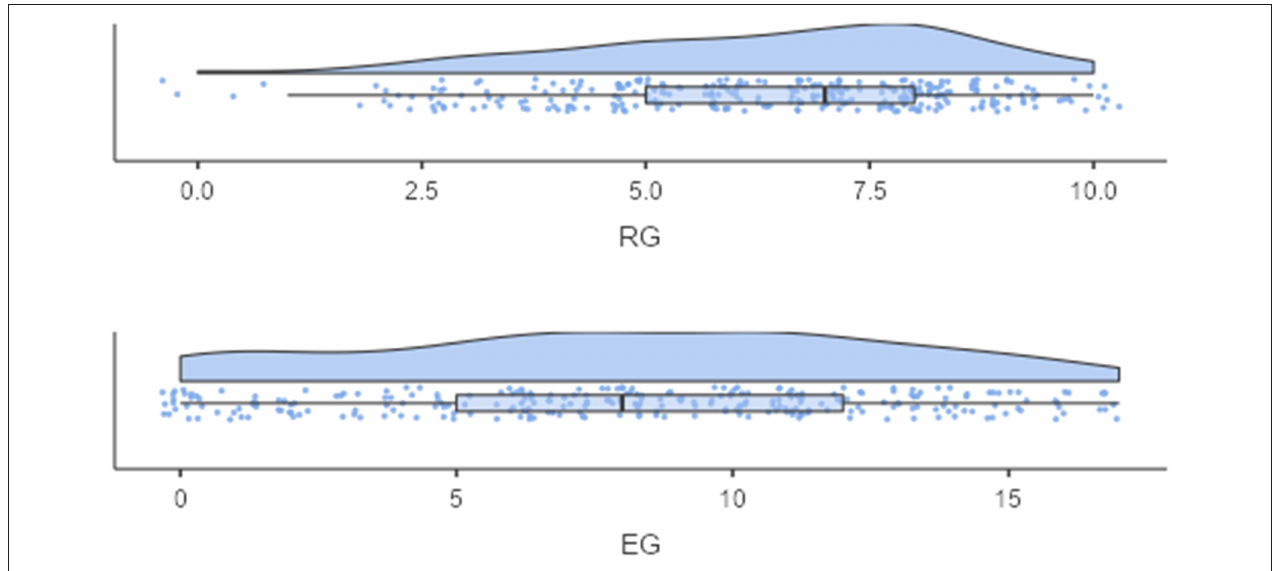
FIGURE 2 | Distribution of the screening subscales—Study 2.